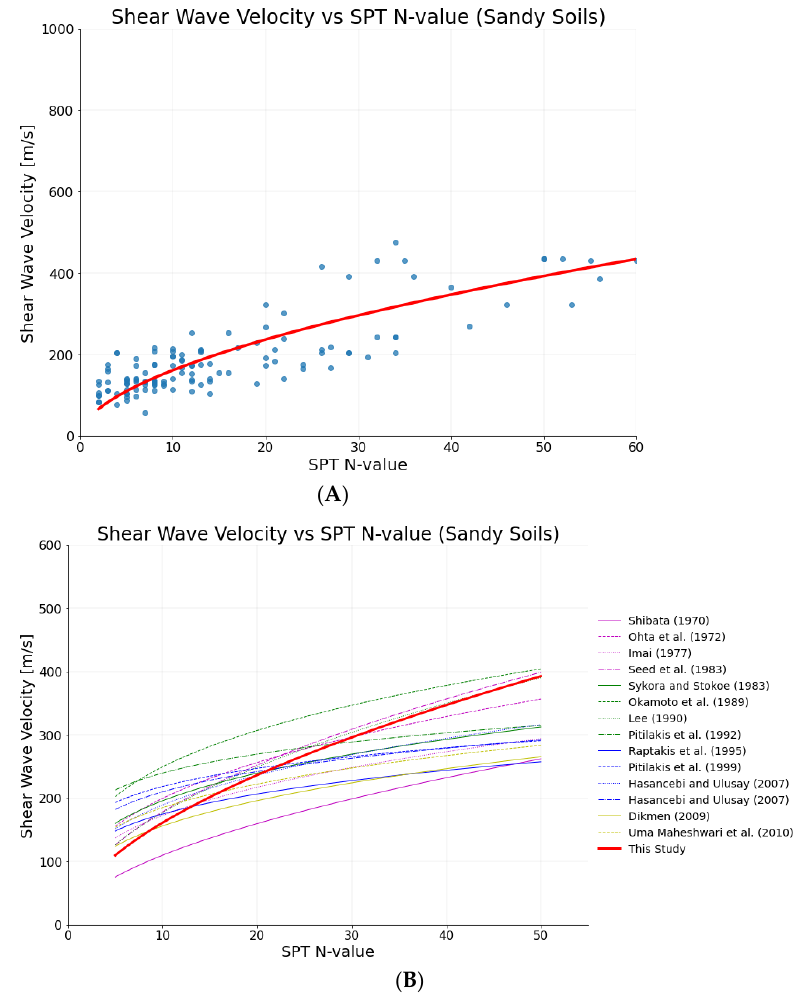
Figure 5. ( A ) . Uncorrected SPT-N and V s pairs for sandy soils and the determined empirical corre- lation . ( B ) . Comparison of the proposed empirical correlation for sandy soil types and other pub- lished works [10,11,14,18,22,24,28,30,35,55,59,60,62]. works